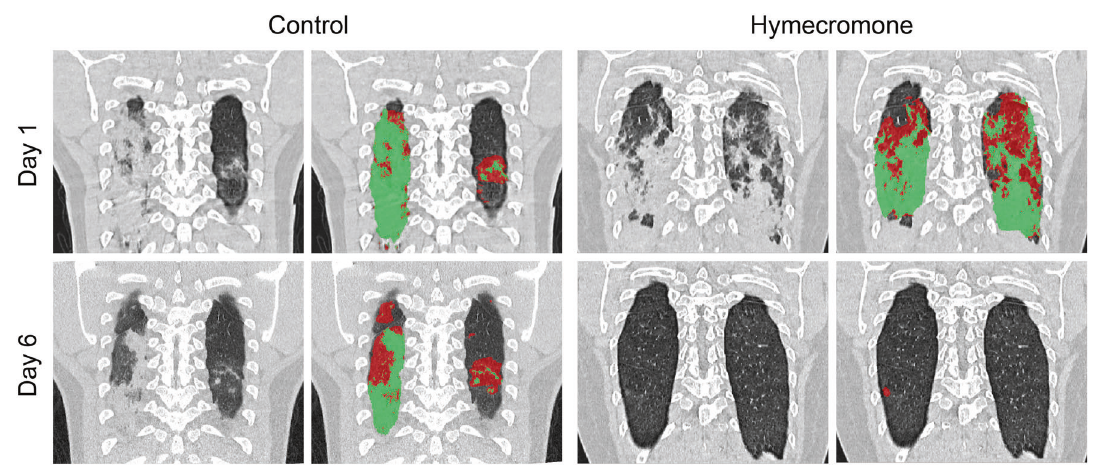
Fig. 7 Represented CT images of COVID-19 patients with support or hymecromone treatment. The original CT results are shown in black-and- white images of two groups while the marked lesion regions of CT results are shown in color images of two groups. Red regions indicate GGO, and green regions indicate consolidation